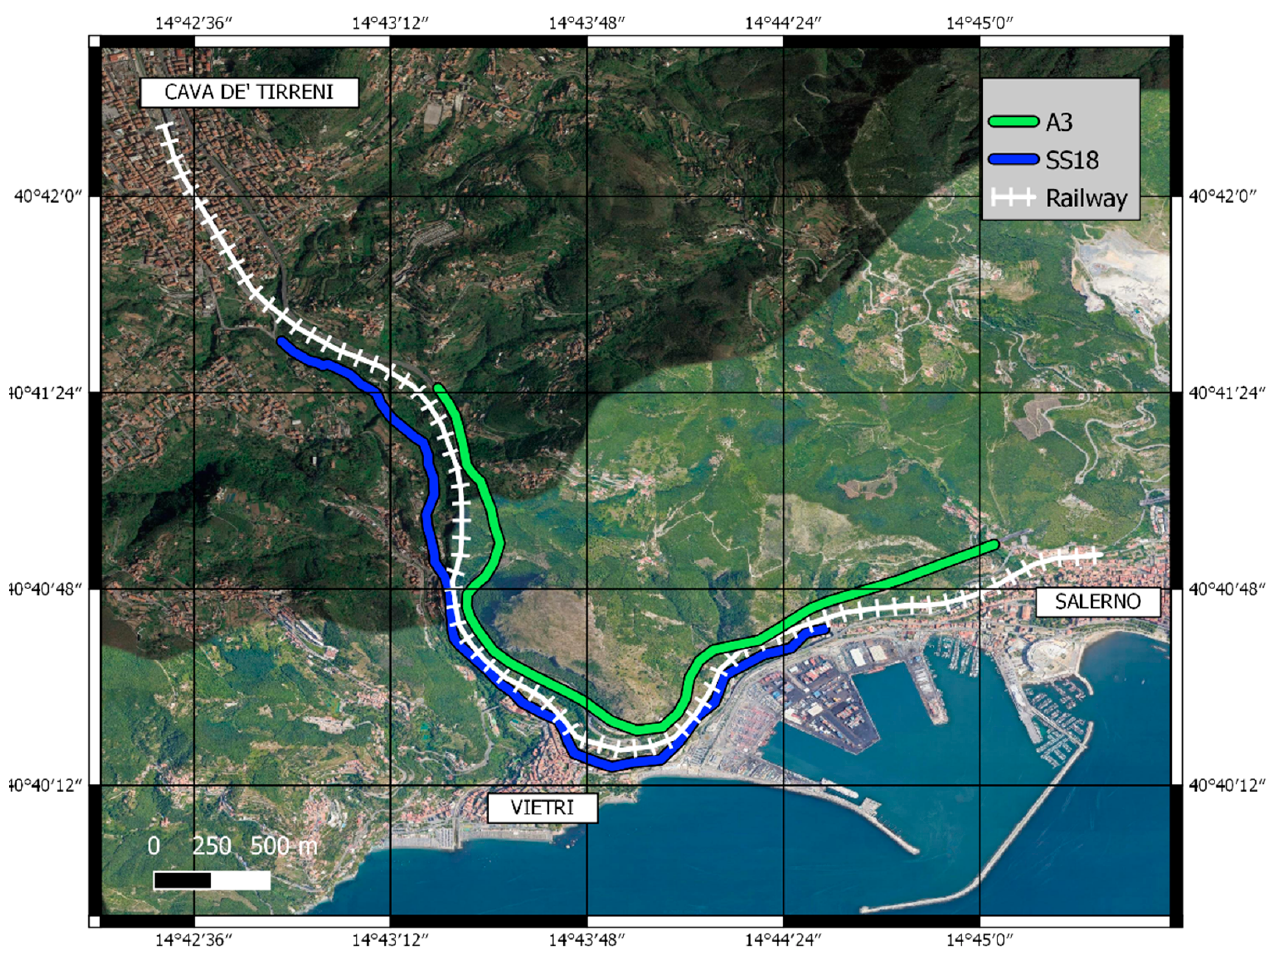
Figure 2. Geographical framework of the overall experimental campaign (Reference System: WGS84 UTM33N—Basemap: Google Satellite).